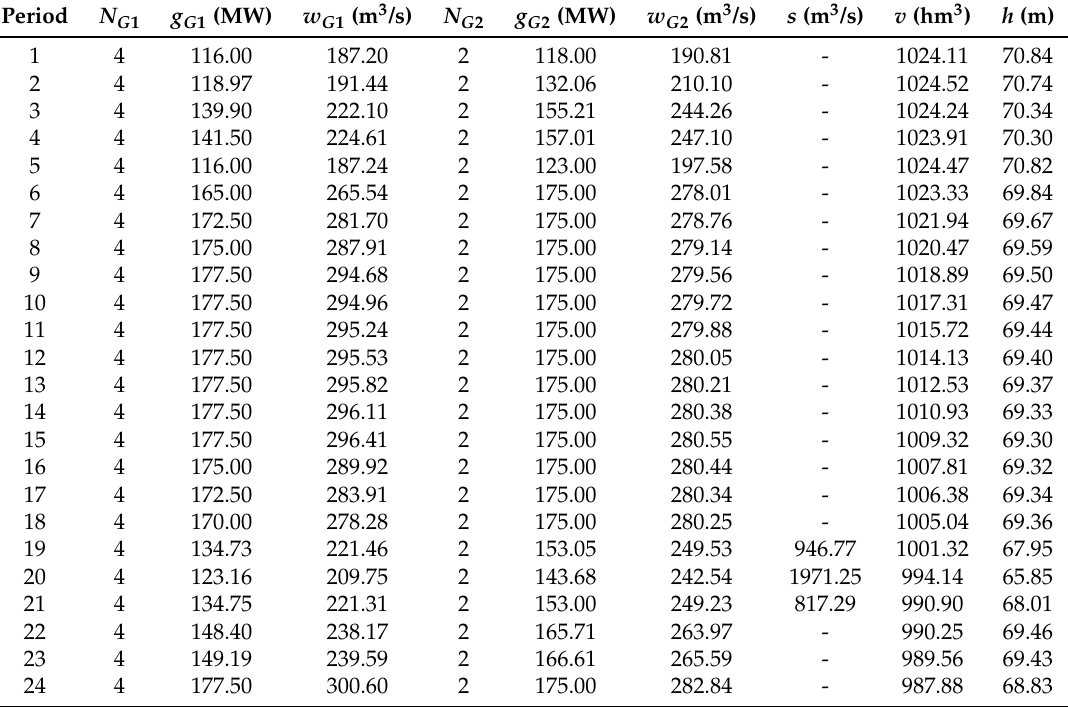
Table 8. Results with power losses-based objective function-scenario